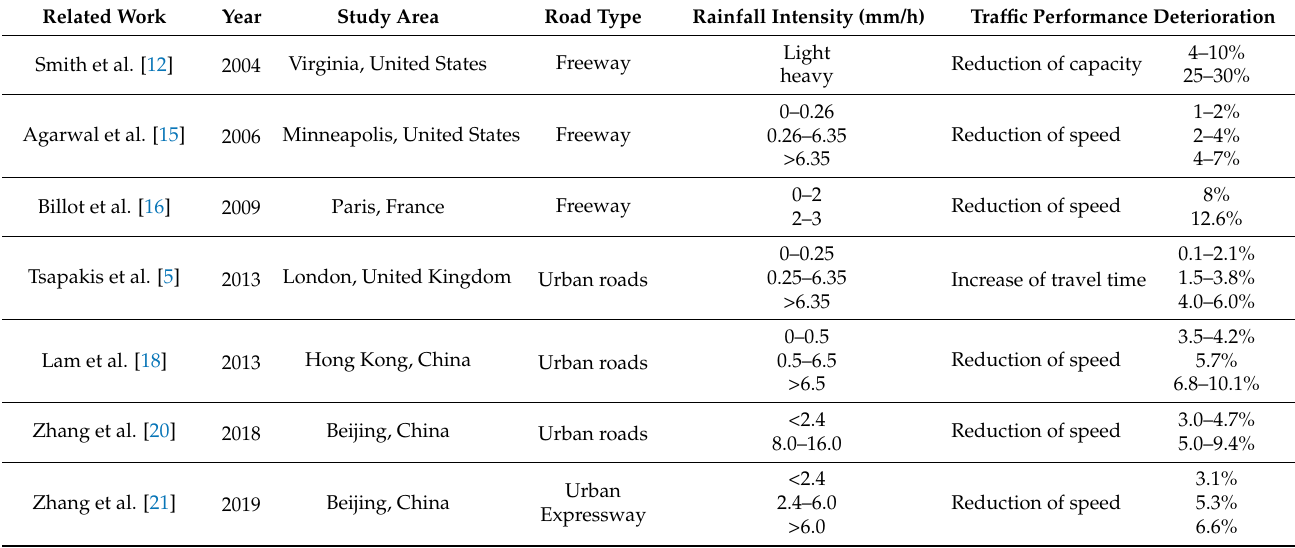
Table 1. Summary of selected research on the effect of rainy weather on traffic performance